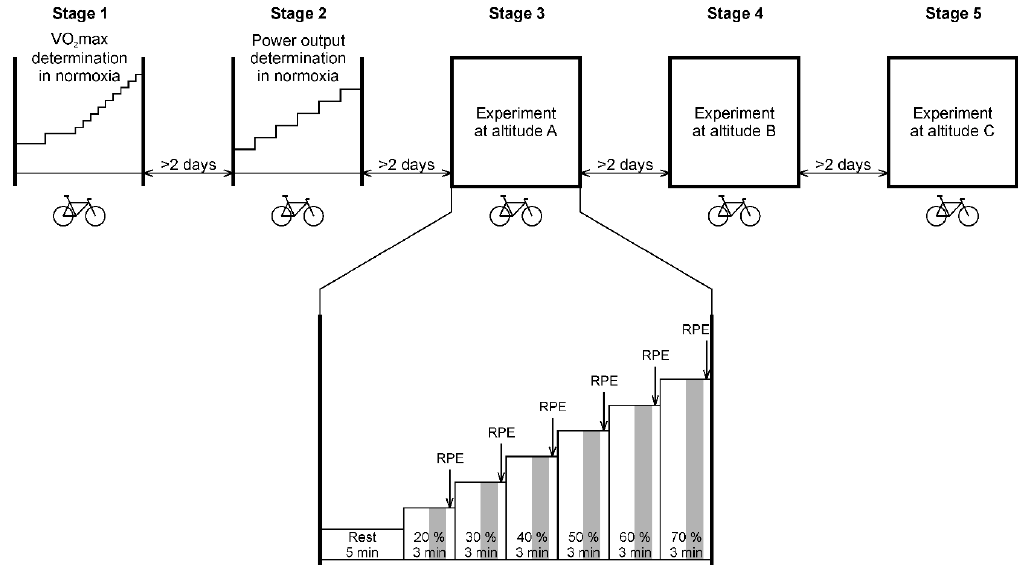
Figure 1. Course of experimental protocol. Altitudes marked A, B, C were randomly assigned to normoxia and two levels of normobaric hypoxia. Gray rectangles denote 1-min segments for calculating average values of heart rate variability, oxygen saturation, and ventilatory measures. RPE: rating of perceived exertion, SpO 2 : arterial oxygen saturation.